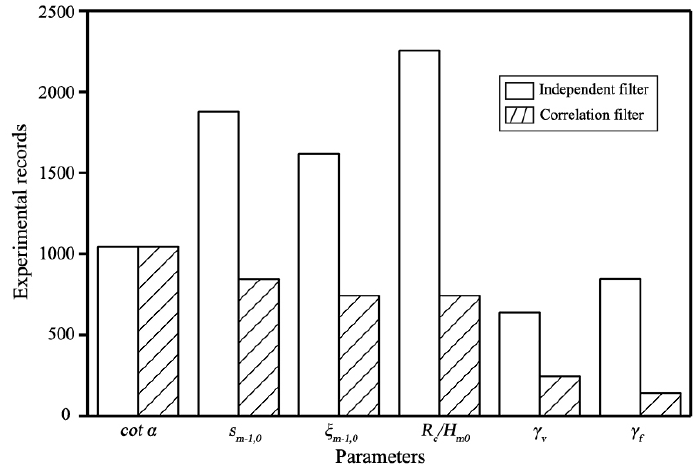
Figure 11. Result of all datasets filtered by Equation (8). Table 3. Comparison of the evaluation index between our model and Van der Meer’s formula.